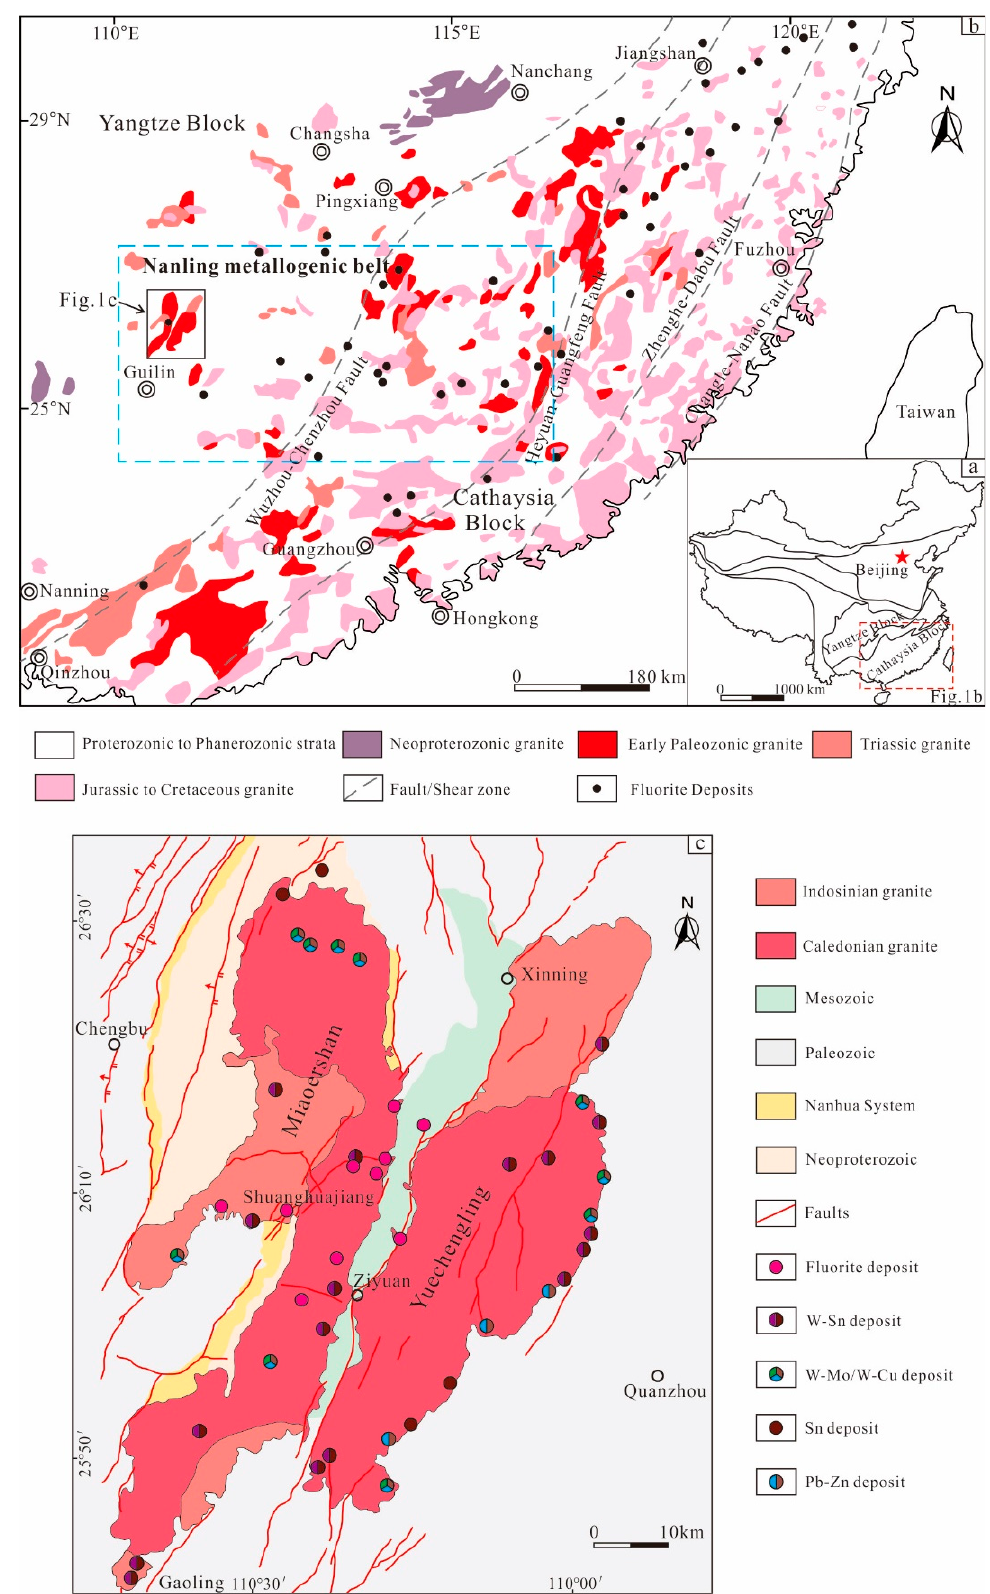
Figure 1. ( a ) Inset map showing location of map ( b ); ( b ) Distribution of granites and associated fluorite deposits in South China (modified after [28,30]); ( c ) Geological map of Miaoershan-Yuechengling district (modified after [28]).